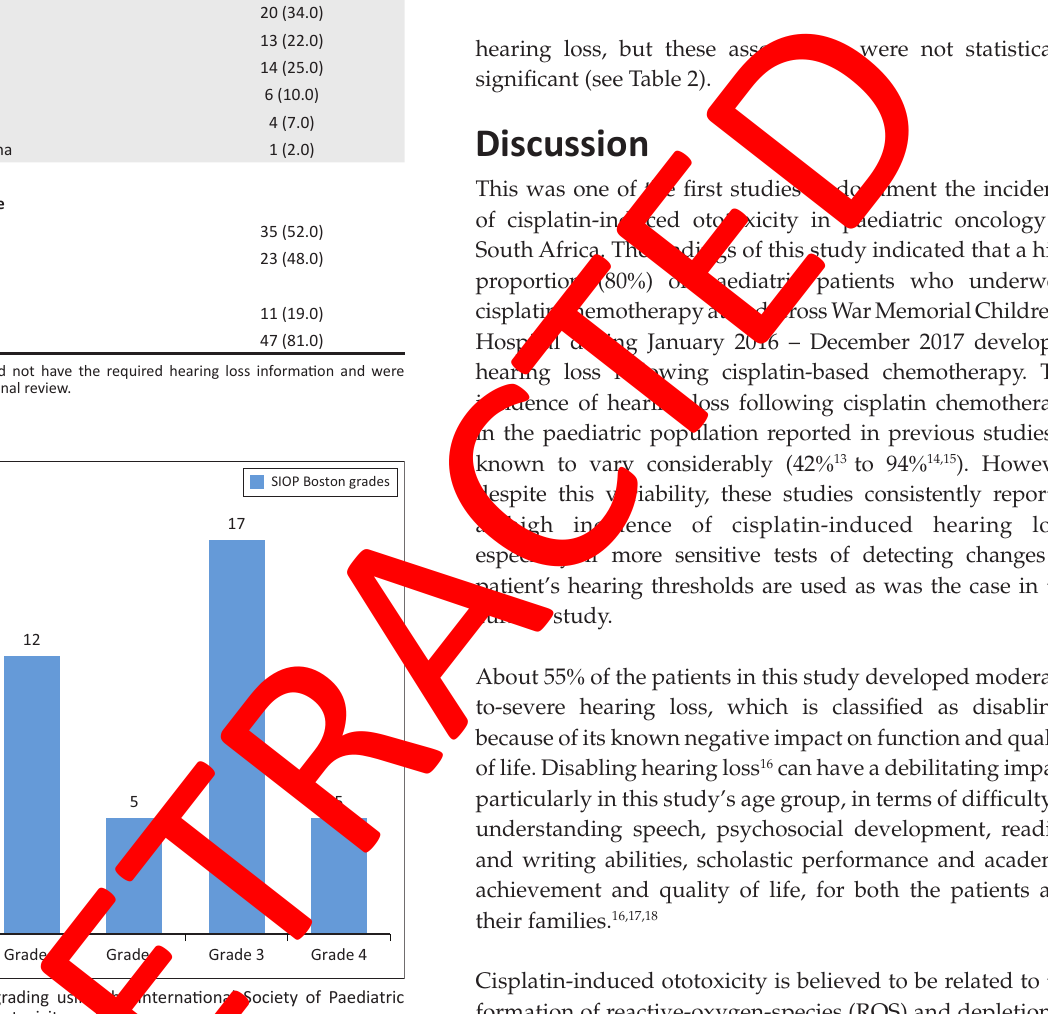
FIGURE 1: Hearing loss grading using the International Society of Paediatric Oncology (SIOP) Boston ototoxicity scale.